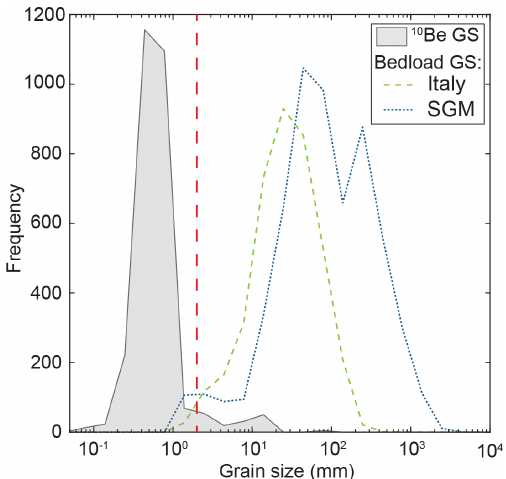
Figure 1. Grain size (GS) distributions of bedload sediment in rivers and grain sizes used for 10 Be-derived catchment-average de- nudation rates ( 10 Be GS, n = 2735) (Codilean et al., 2018). Bed- load grain size distributions were measured by pebble counts in bedrock rivers in Southern Italy and Sicily (Italy, n = 3900) (Allen et al., 2015; Roda-Boluda et al., 2018) and the San Gabriel Moun- tains (SGM, n = 5930) (DiBiase and Whipple, 2011; Scherler et al., 2016). Wolman pebble count fractions classified as <2mm are shown as 1mm in the figure. Dashed line indicates